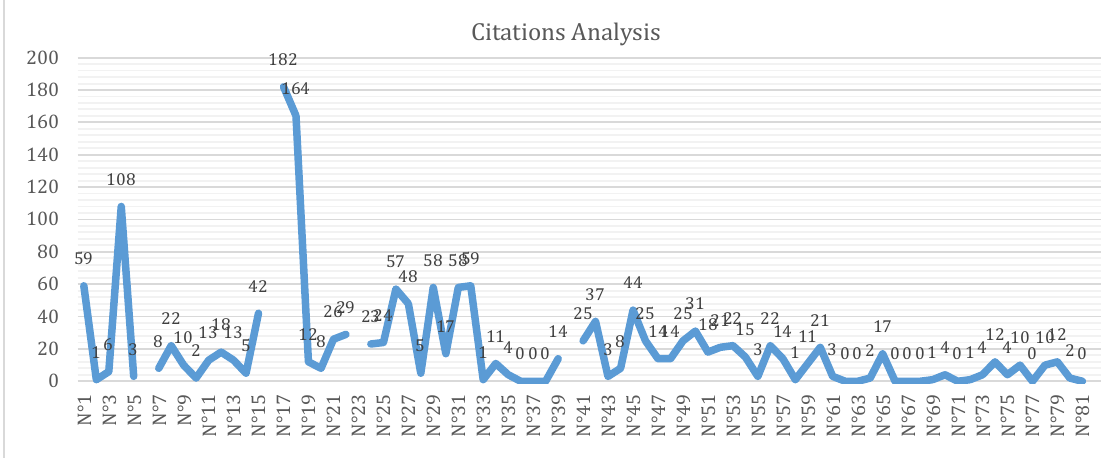
Figure 3: Distribution of the articles’